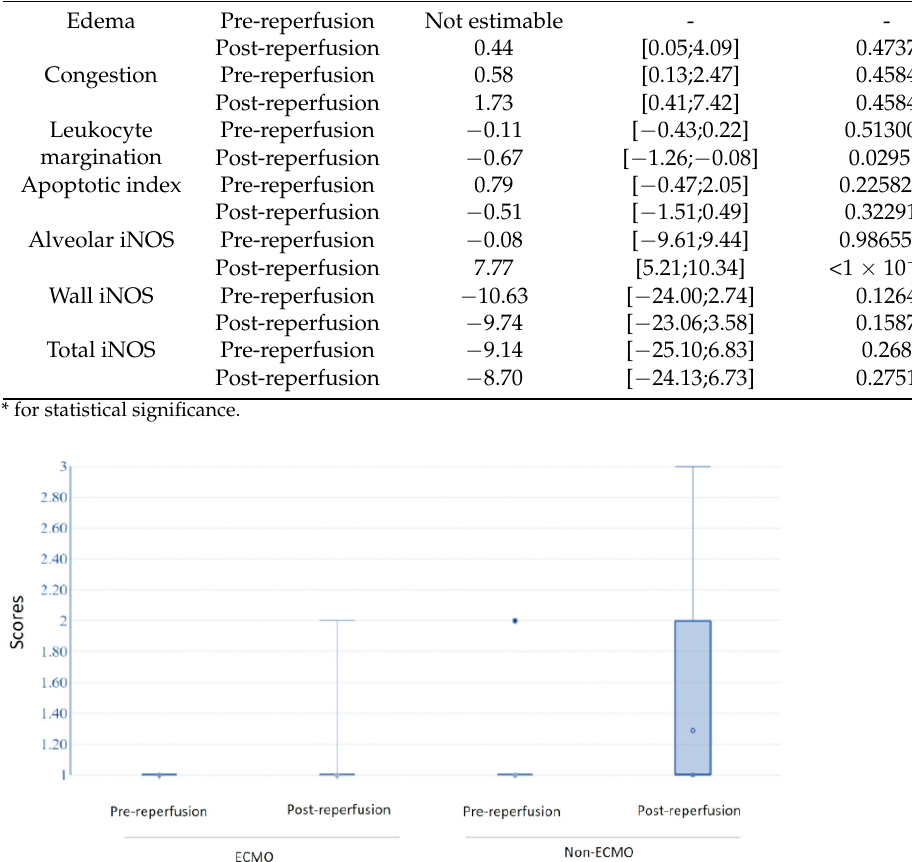
Figure 6. Leukocyte margination increasing between pre- and post-reperfusion biopsies in the ECMO and non-ECMO groups.